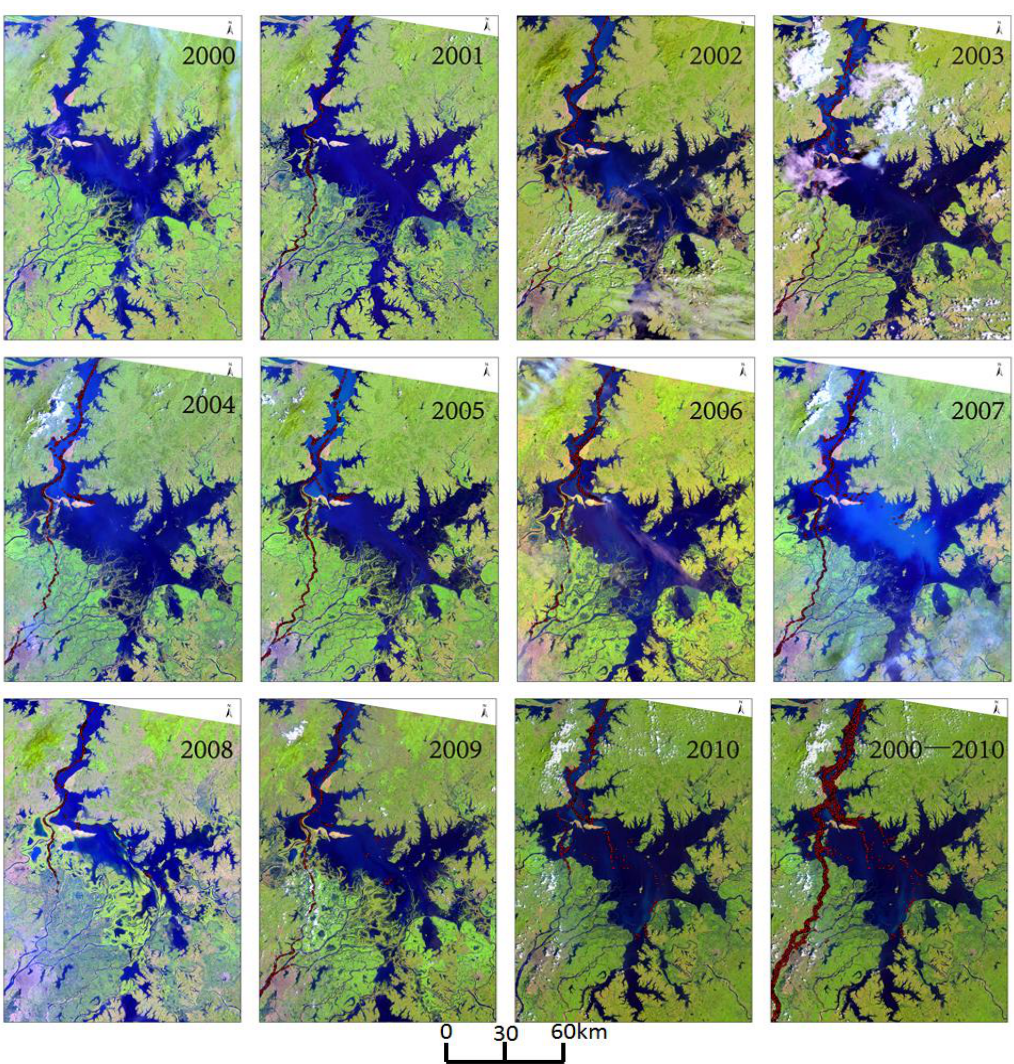
Figure 4: Distribution of dredging vessels detected from Landsat image during 2000-2010 (Note: The red dot was used as legend for